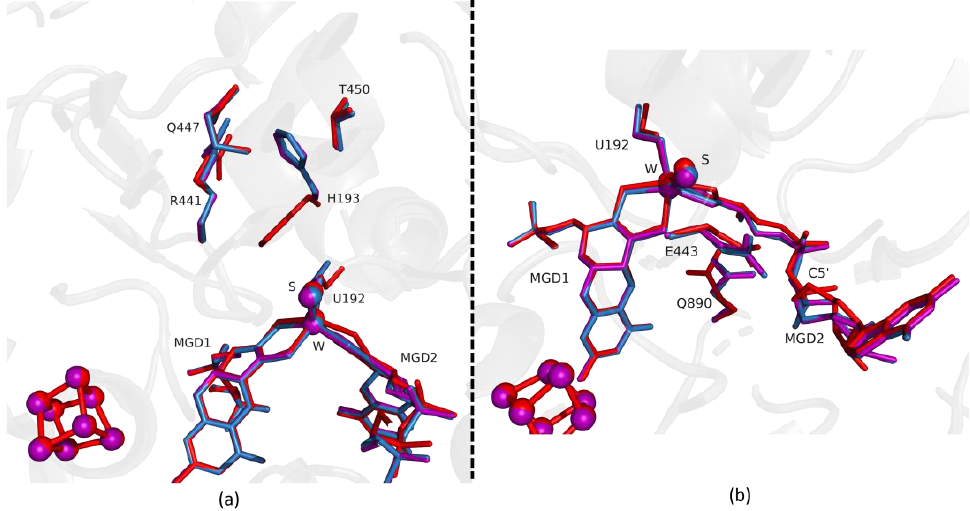
Figure 5. Superposition of Dv FdhAB as-isolated (red), formate reduced (violet) and formate-soaked Fdh_22min structure (dark blue) in two different orientations. ( a ) U192, H193, R441, Q447, T450 and the two MGD co-factors are shown as sticks. ( b ) U192, E443, Q890 and the two MGD co-factors (note the C 5′ atom of MGD2) are shown as sticks.